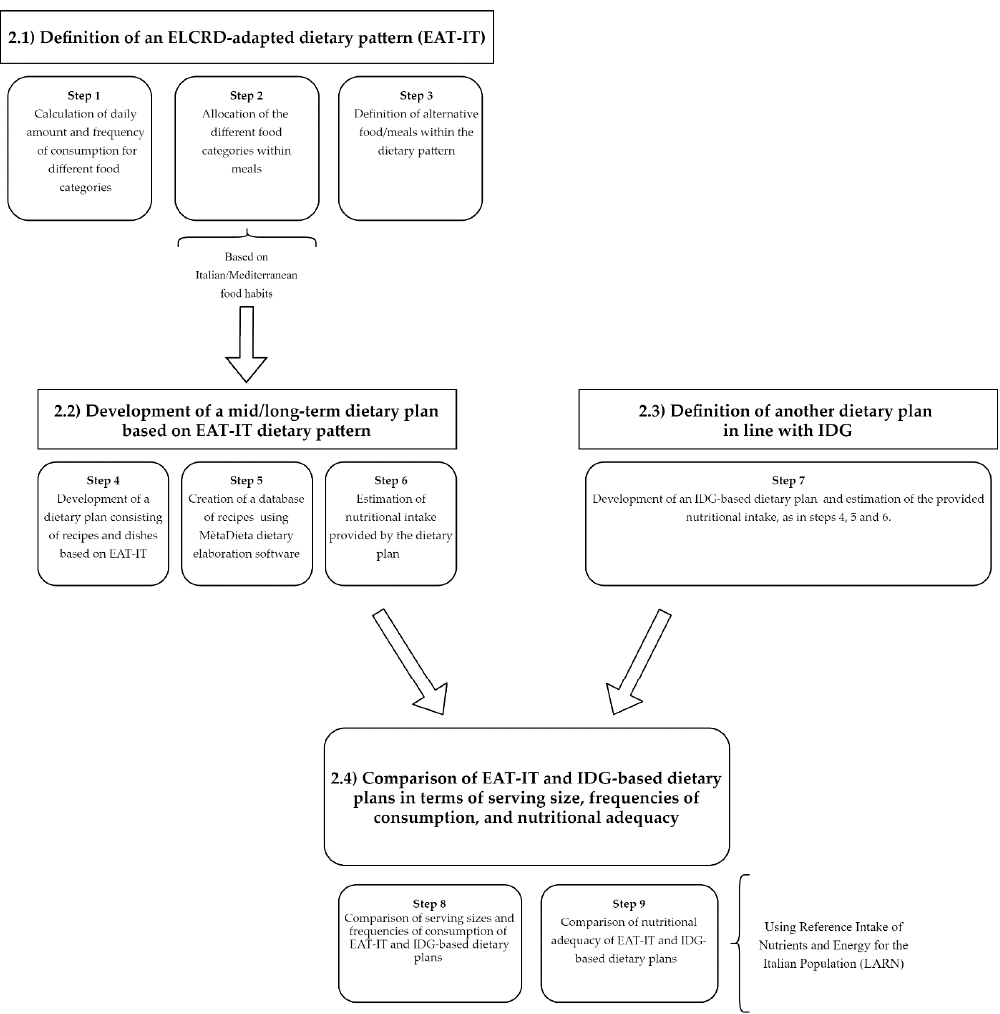
Figure 1. Overview of the protocol used for the development and analysis of the dietary pattern based on the EAT-Lancet Commission Reference Diet (ELCRD) that was adapted by considering the Mediterranean/Italian food habits (EAT-IT). IDG: Italian dietary